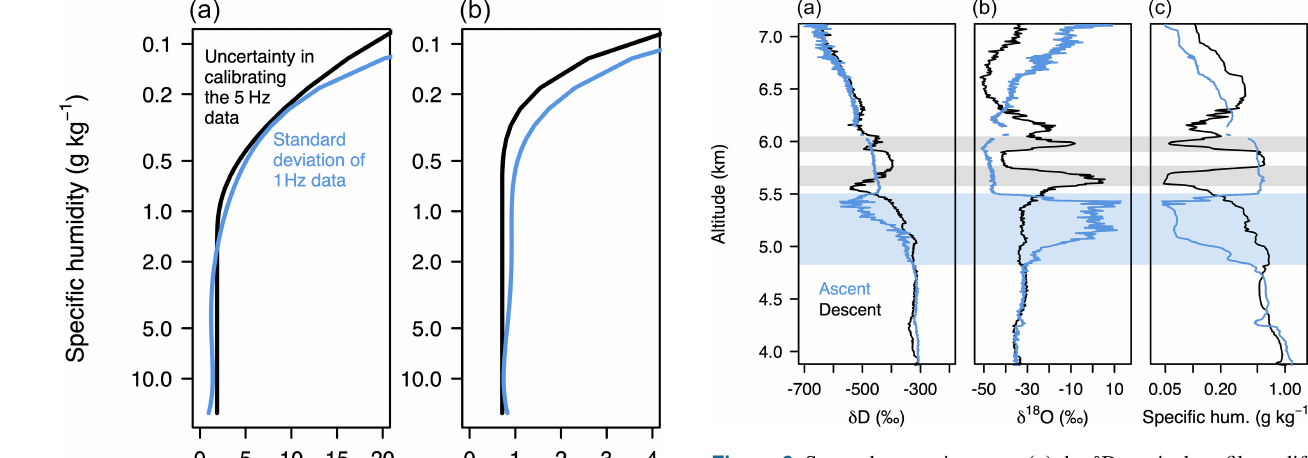
Figure 9. Strong hysteresis causes (a) the δ D vertical profile to dif- fer substantially from vertical profiles of (b) δ 18 O and (c) specific humidity during aircraft ascents (blue) and descents (black) on P-3 Research Flight 8. Three dry layers, in which the delayed response and weaker signal in δ D are most evident, are indicated by shad- ing. δ 18 O is characterized by a better time response than δ D but shows unphysical enrichment at altitude due to a shifting humidity- dependent bias over the course of the